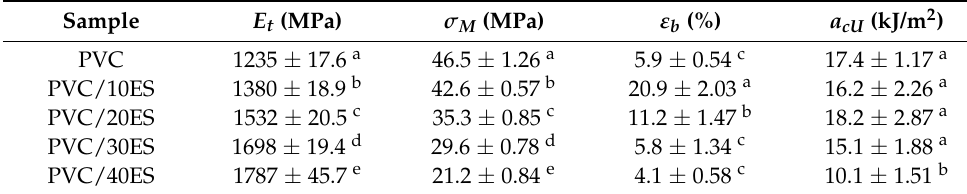
Table 4. Mechanical properties of PVC and PVC/ES composites.